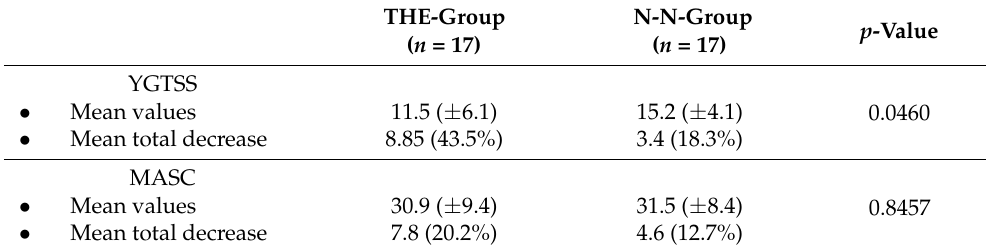
Table 3. Comparisons between mean YGTTS and MASC values at